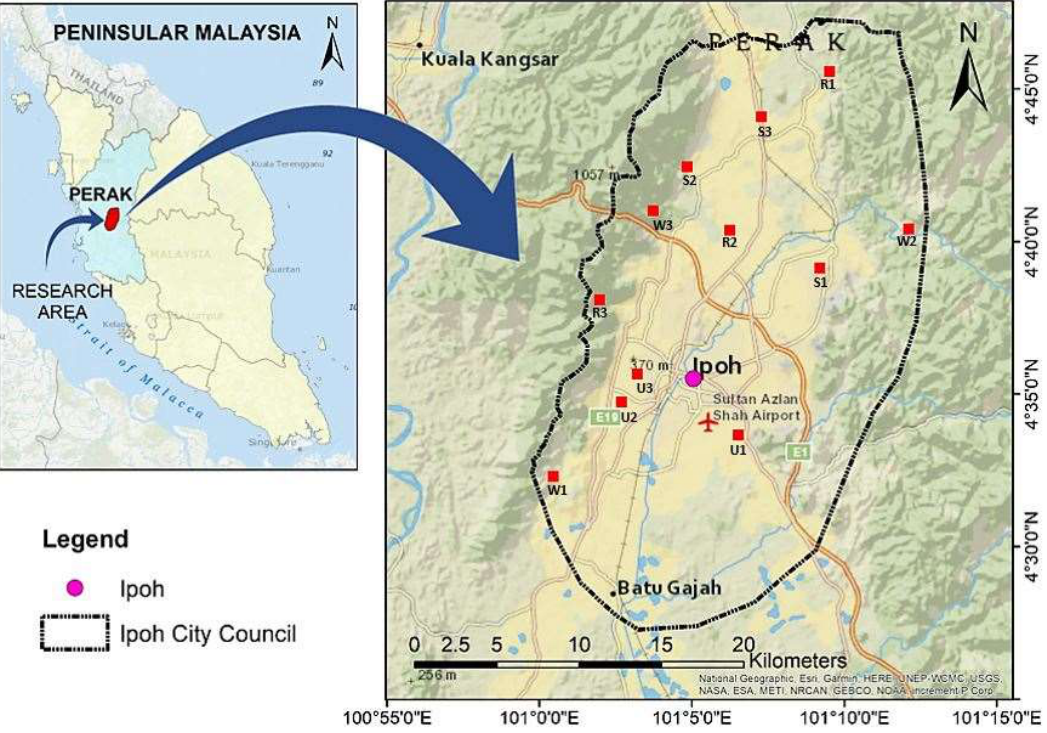
Figure 1. Study area in Ipoh, Perak in Peninsular Malaysia where 12 sampling plots represented an urbanization gradient. W: wildland, R: rural, S: suburban, U: